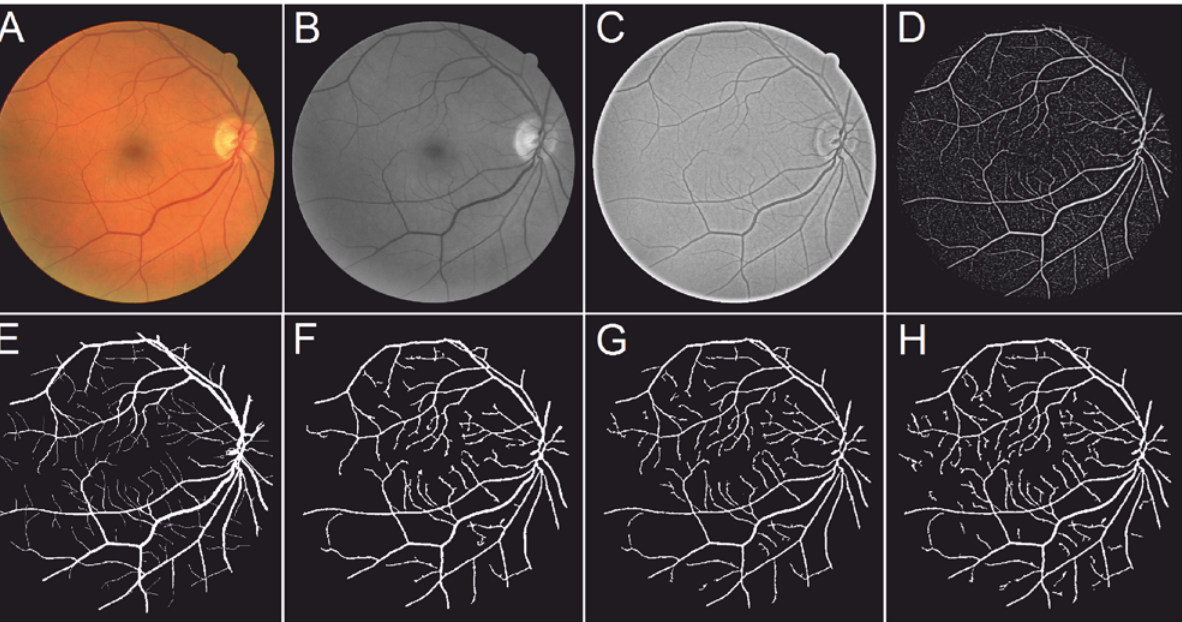
Fig 7. Overview of the main steps of our method and the comparison results obtained with other two segmentation methods. (A) A randomly chosen image from the DRIVE dataset. (B) The green channel of (A): this channel has the highest contrast between regions of vessel and the background. (C) Results after applying Retinex on (B). Retinex successfully enhances the contrast between vessels and background, and the vessels are more easily identifiable. (D) Local phase map of (C): the edges of the vessels are enhanced, and made more visible, to make the vessel stand out further from the background. (E) Expert ’ s annotation. (F)-(H): Segmentation results with the level set (LS), Total variation (TV), and graph cut (GC) based segmentation methods,